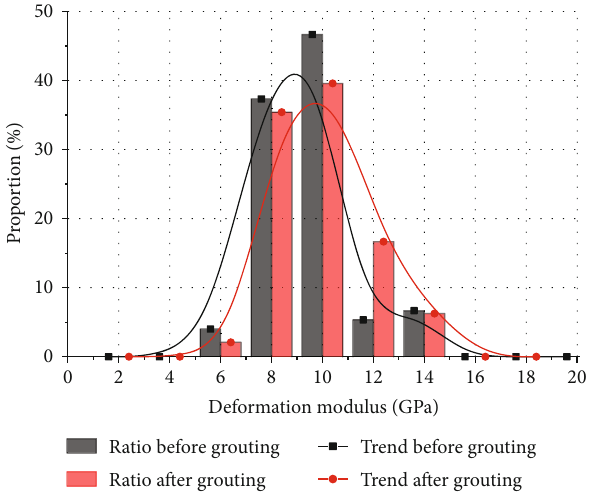
Figure 13: Distribution of deformation modulus after